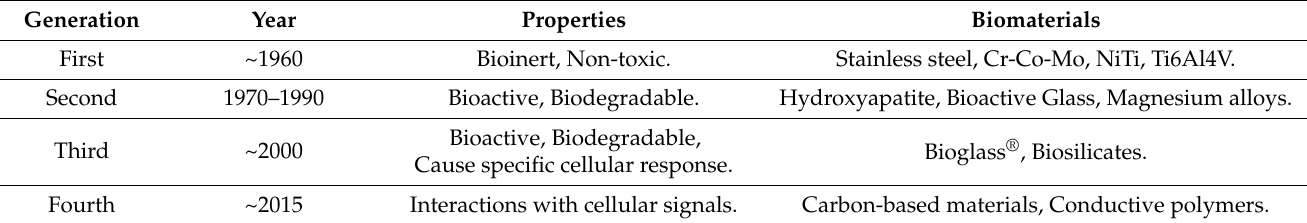
Table 1 summarizes the different generations of biomaterials. Table 1. Different generations of